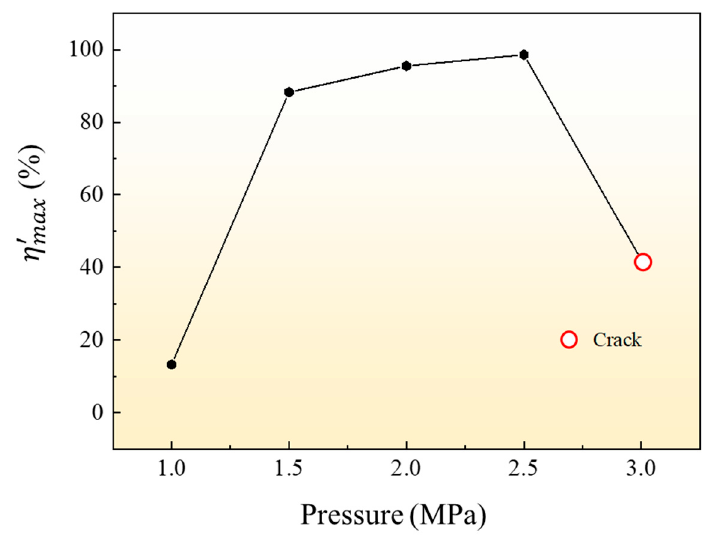
Figure 7. Influence of different pressure on η (cid:48) max at 475 ◦ C.